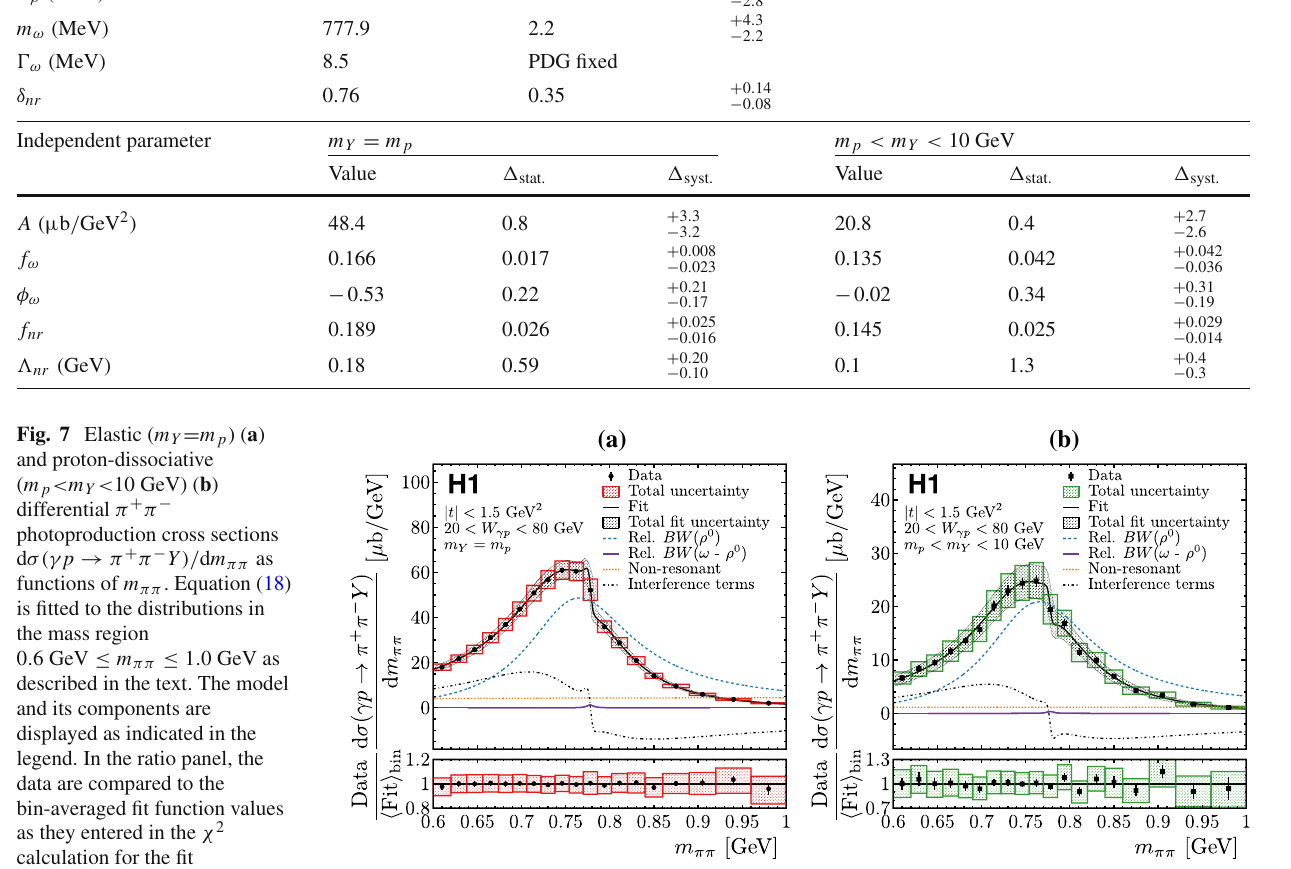
Table 5 Free parameters for the fit of the single-differential elastic and proton-dissociative cross section d σ(γ p → π + π − Y )/ d m ππ as a function of m ππ . The nominal fit values and statistical and systematic Shared parameter Value (cid:20) stat.